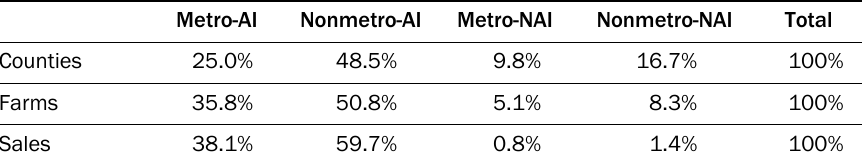
Table 2. Percent of Counties, Farms and Sales by Metro and Agriculturally Importance (AI) or Non-agriculturally Important (NAI) Status, 2007